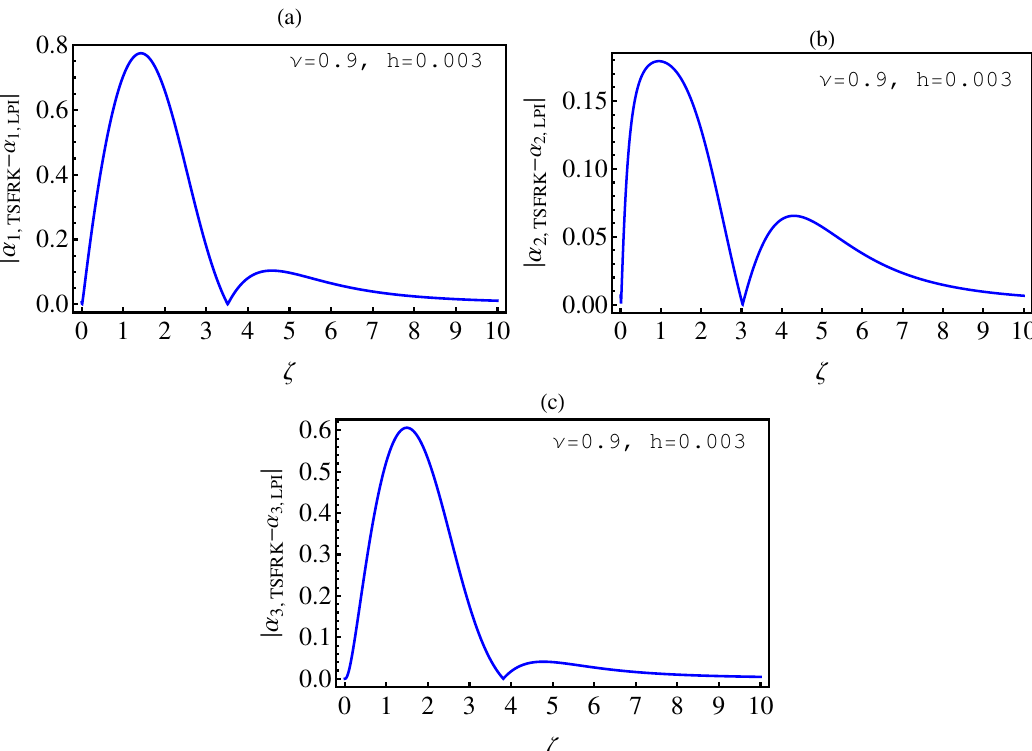
Figure 6. The absolute error between the numerical solutions of (2) to (4) based upon the LPI and the SCM for ν = 0.9, h = 0.03, m = 21, λ = 2, (cid:101) = 1, µ = 2, δ = 1 and for the initial values α 1 ( 0 ) = 0, α 2 ( 0 ) = 1 and α 3 ( 0 ) = λ (( a ), ( b ) and ( c ), respectively).